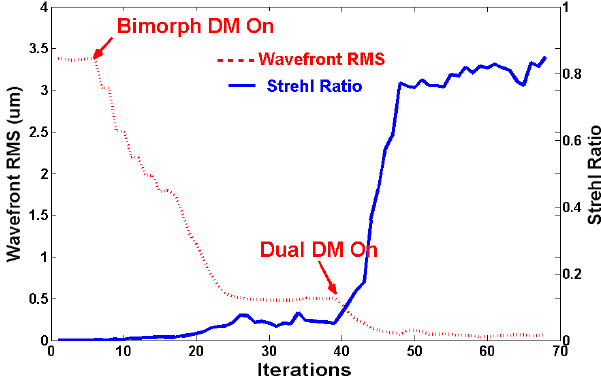
Fig. 8. The RMS wavefront errors and corresponding SR over iterations for Subject LB.